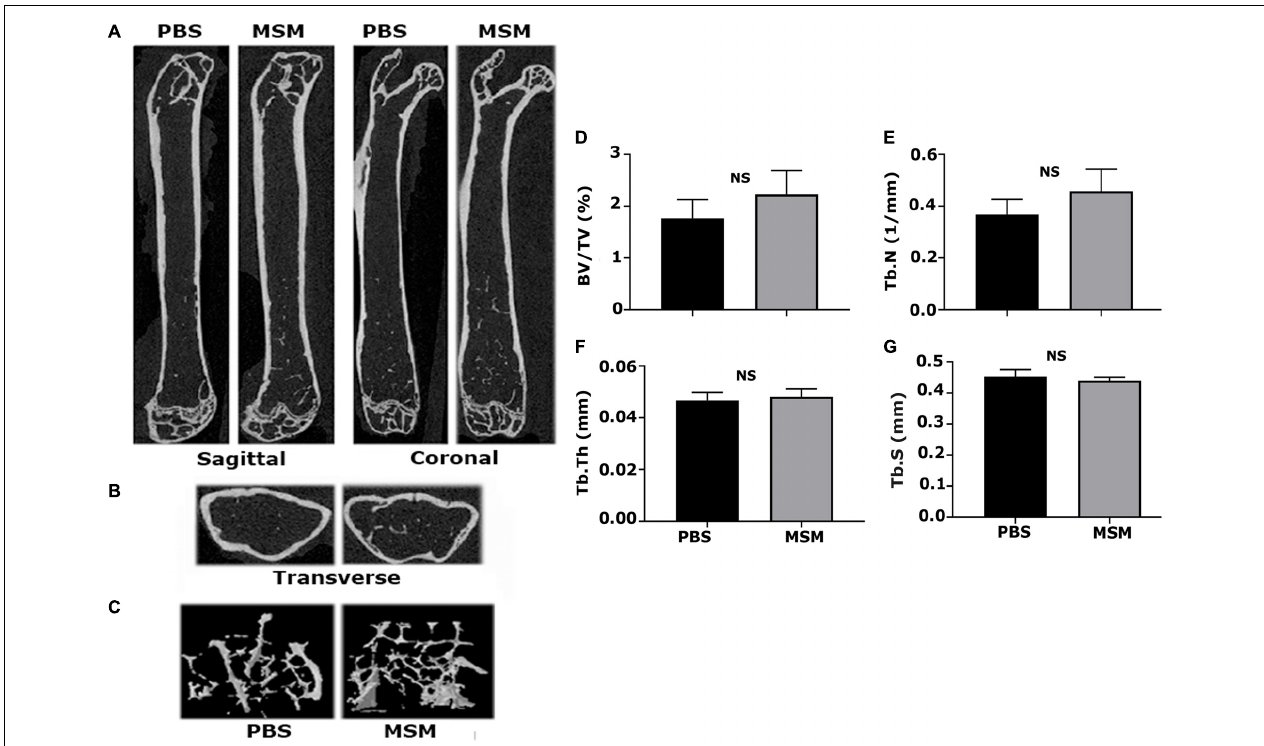
FIGURE 2 | Microcomputed tomography analysis of trabecular and cortical bone isolated from mice femurs injected with PBS and MSM. (A) Representative longitudinal sections of the femur are shown in two different planes, i.e., the sagittal and coronal, (B) The ROI indicated in Figure 1 was used for transverse plane scanning, and (C) For three-dimensional (3D) construction. The micro-CT parameters were compared in six mice femurs injected with PBS and MSM. Statistical analyses were performed using the Mann–Whitney U test for morphometric parameters, including (D) bone volume to tissue volume (BV/TV), (E) trabecular number (Tb. N) and (F) trabecular thickness (Tb. Th), and (G) trabecular spacing (Tb. S), all shown as bar graphs. Data are shown as the mean ± SEM; NS, not statistically